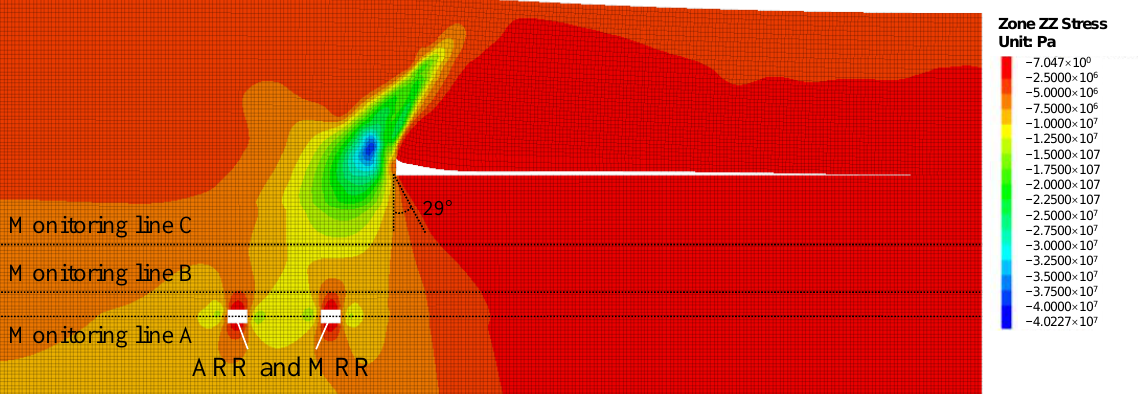
Figure 4. Cloud chart of surrounding rock stress under the action of residual pillar in working face 31,106.